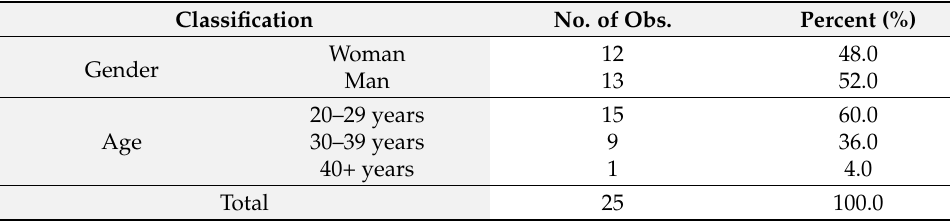
Table 2. The characteristics of participants. Classification No. of